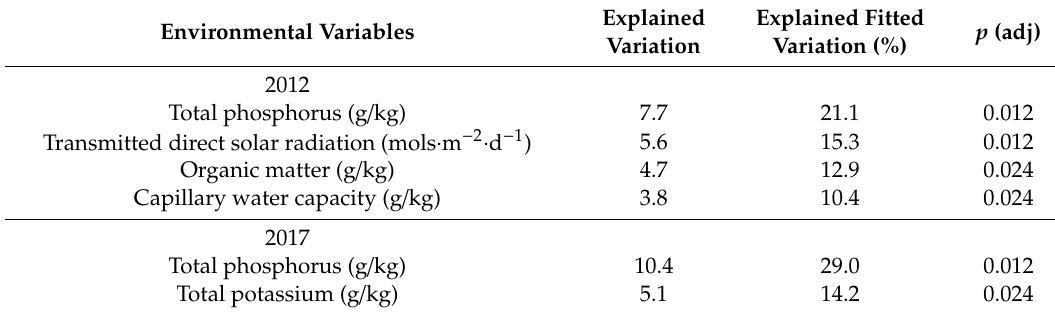
Table 7. E ff ects of environmental variables on species